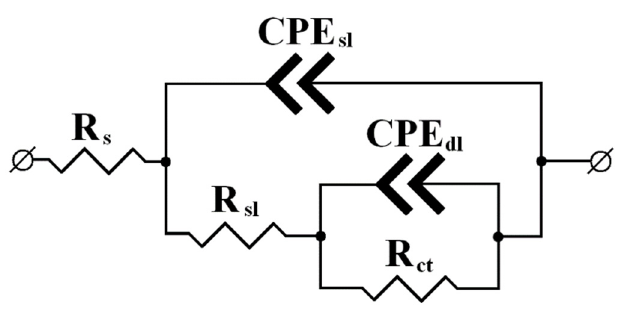
Figure 1. Equivalent circuit used to fit impedance data.